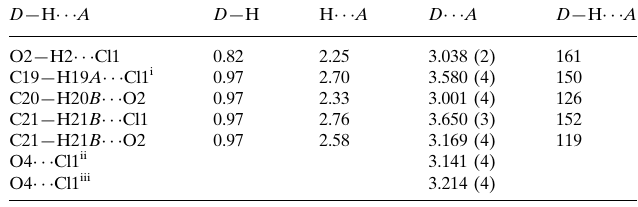
Hydrogen-bond geometry (A˚ , (cid:4)